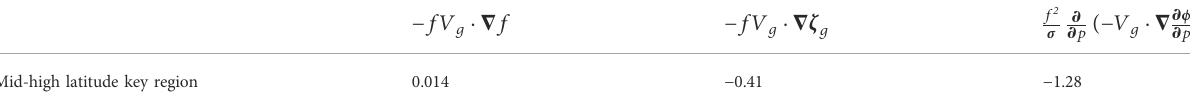
TABLE 2 Quasi-biweekly components of geopotential tendency equation over the mid-high latitude key region (unit: 10 − 10 s − 2 ).